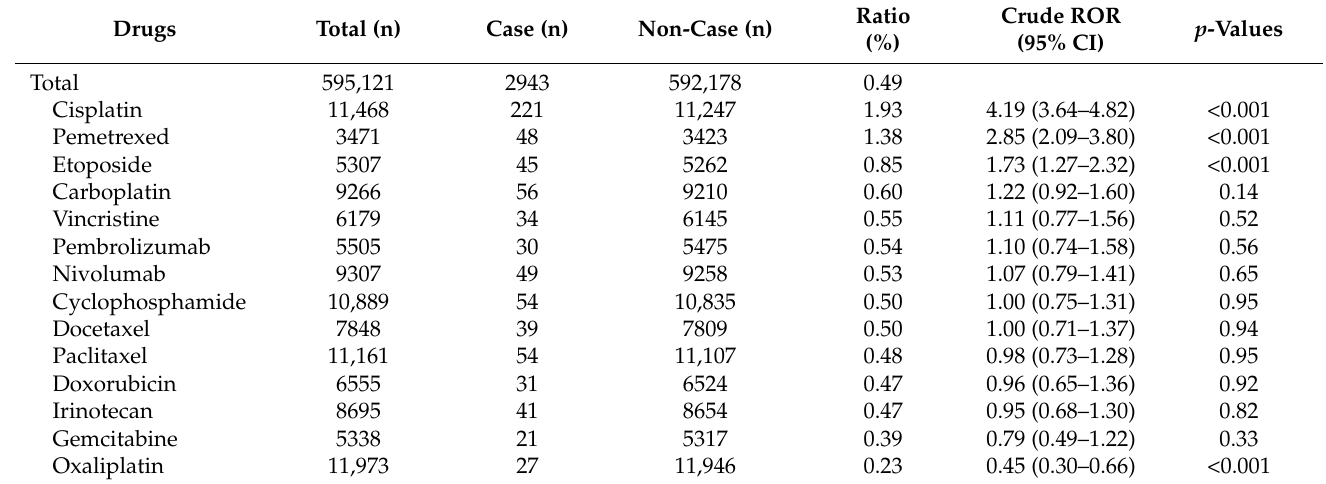
3.2. Crude RORs and the Number of Cases of Each Cancer Site Associated with Hyponatremia The crude ROR (95% CI) for each cancer site related to hyponatremia in the JADER database was calculated.